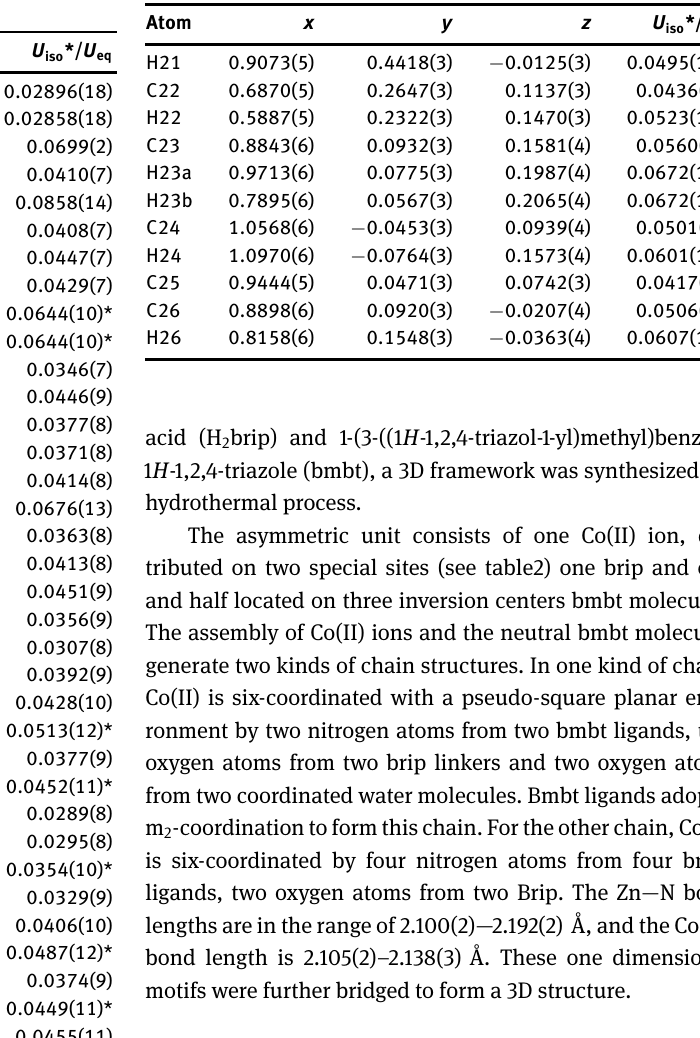
Table 2: Fractional atomic coordinates and isotropic or equivalent isotropic displacement parameters (Å 2